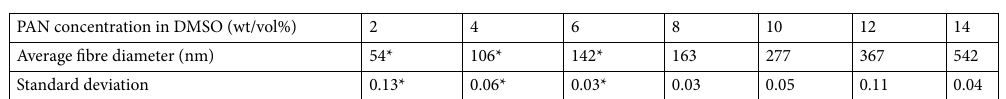
Table 1. Average fibre diameter for specified PAN/DMSO concentrations. *Indicates beaded fibres.